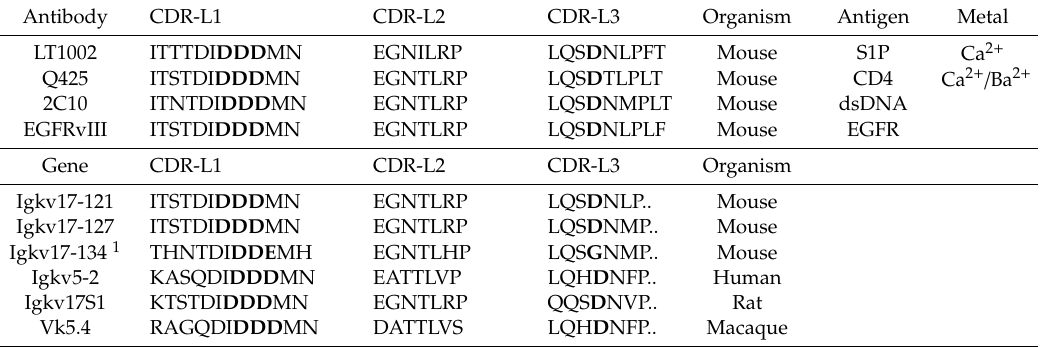
Table 2. Conservation of LT1002 metal-contacting residues (bold) in CDR-L1 and